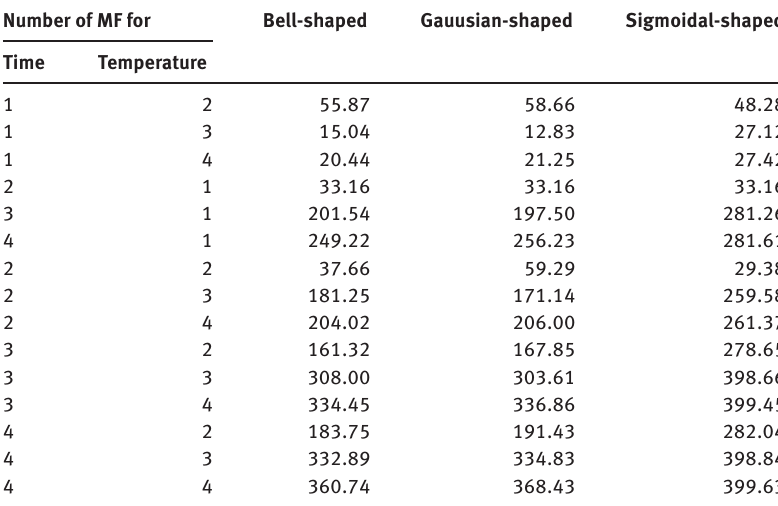
Table 3 RMSE of utilizing various membership